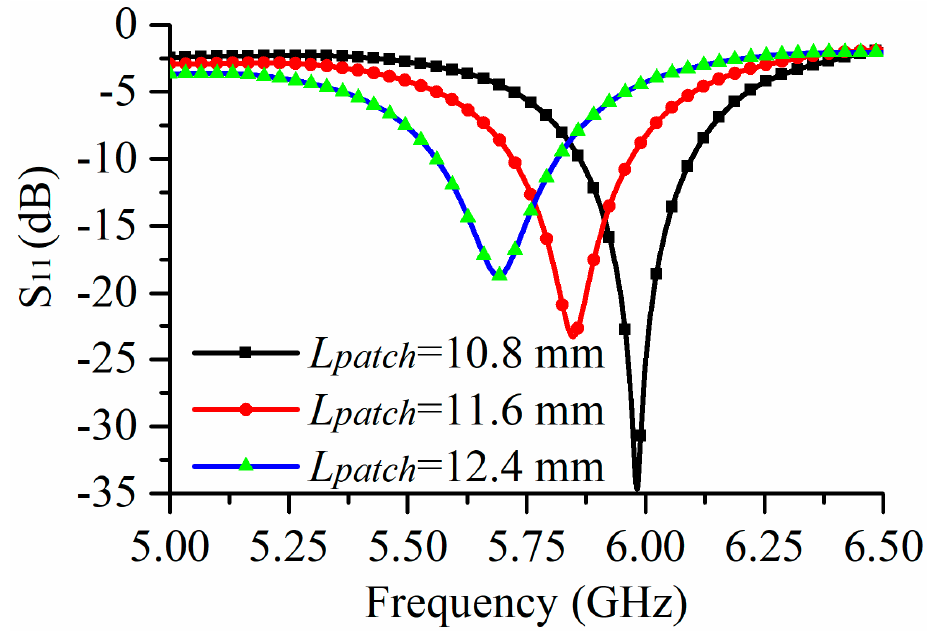
Figure 3. Simulation S 11 under different values of L patch .